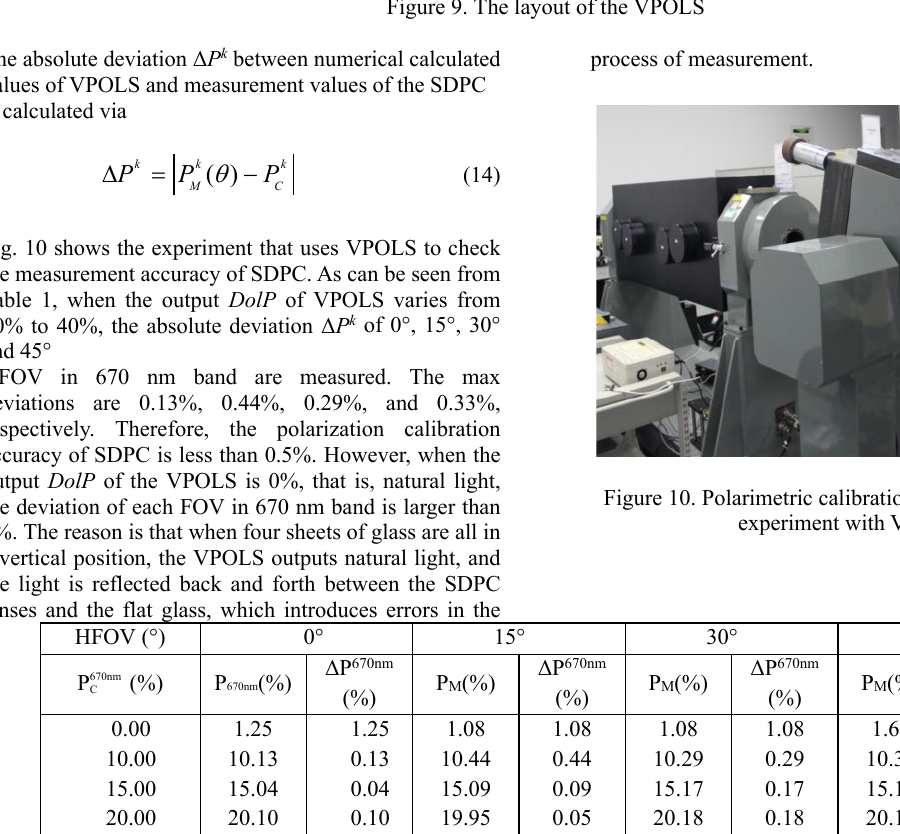
Figure 9. The layout of the VPOLS